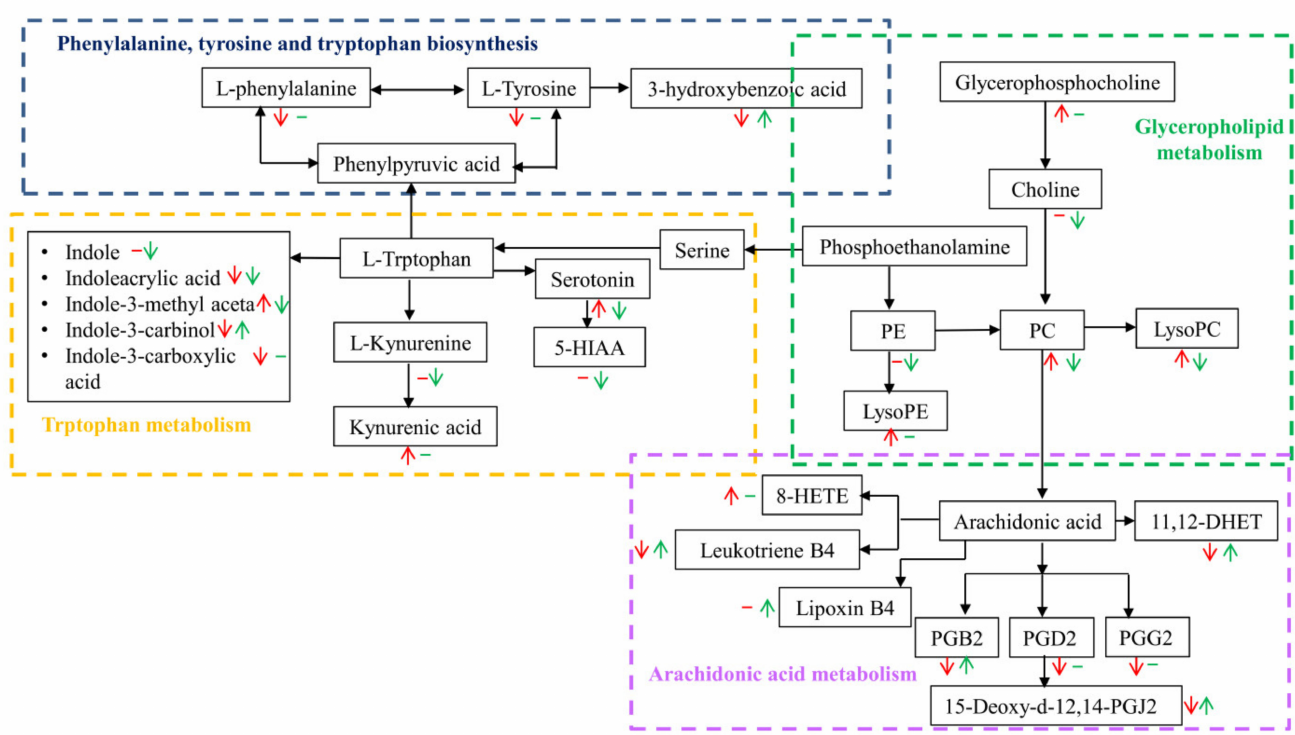
Figure 5. Manually linked metabolic pathway map based on the KEGG database involving glyc- erophospholipid metabolism, tryptophan metabolism, arachidonic acid metabolism, and phenylala- nine, tyrosine, and tryptophan biosynthesis metabolism. Beneath each metabolite, red represents HF versus CT group and green represents HF4H versus HF group. The up arrows showed the metabolites were up-regulated and the down arrows showed the metabolites were down-regulated. Horizontal lines showed no significant difference in